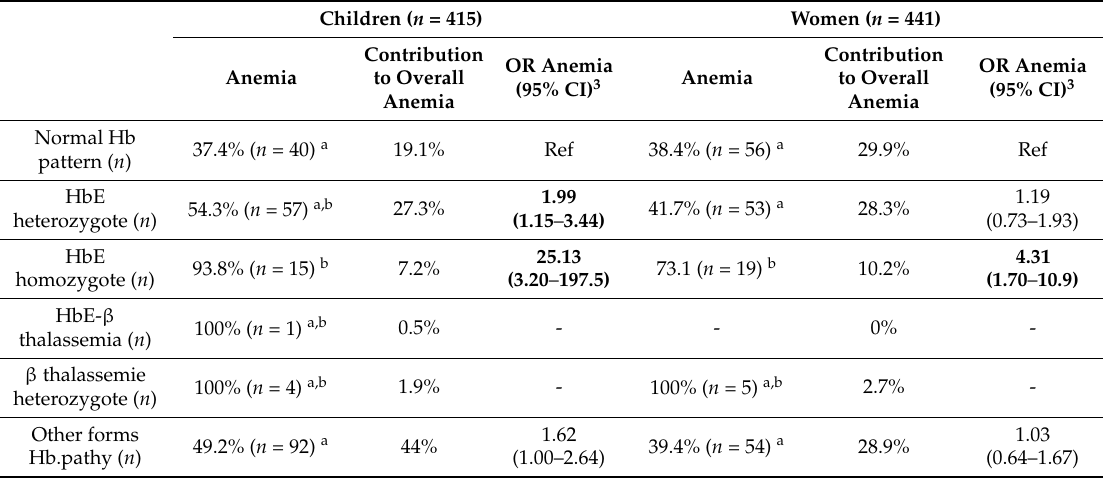
Table 3. Anemia prevalence and hemoglobinopathy in children and women of reproductive age 1,2